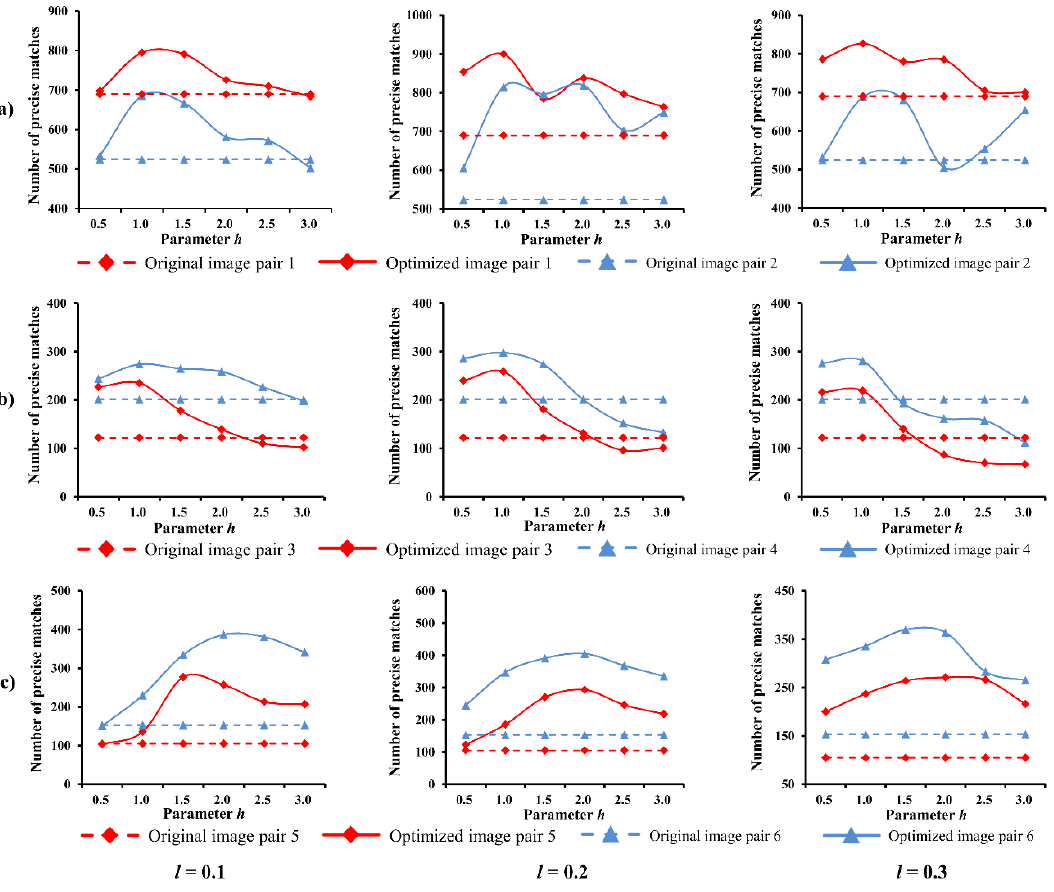
Figure 12. Parameter influence on image matching: ( a ) weak illumination; ( b ) normal illumination; ( c ) bright illumination.